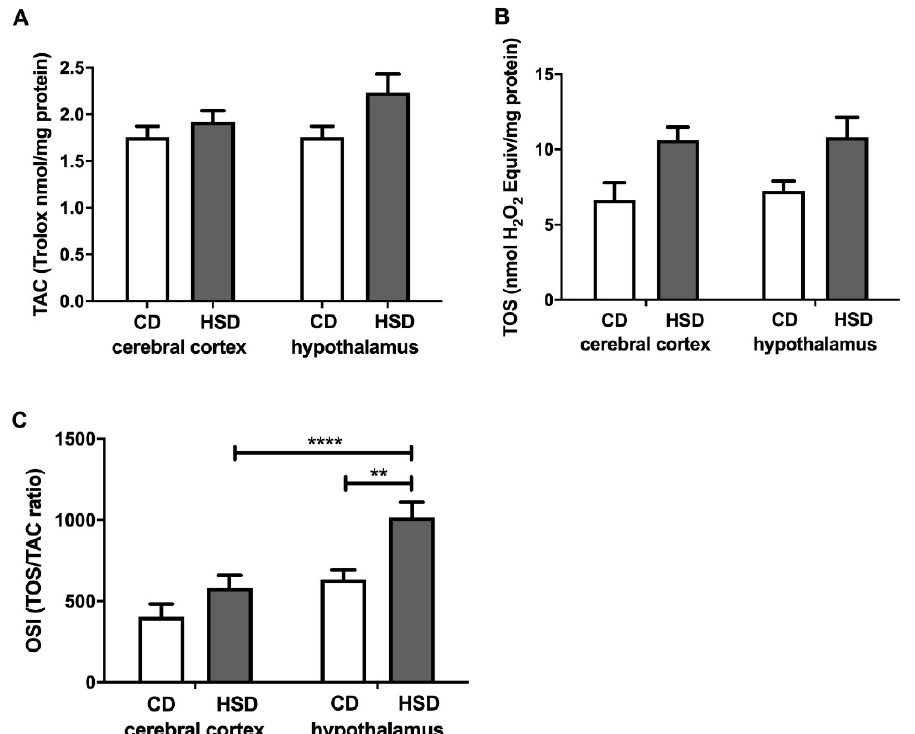
Figure 4. Brain redox status (total antioxidant capacity ( A ), total oxidative status ( B ) and oxidative stress index ( C )) in the control and HSD-fed rats. Values are means ± SEMs; n = 10, ** differences statistically important at p < 0.005 and **** p < 0.0001. CD—control diet; HSD—high-sucrose diet;